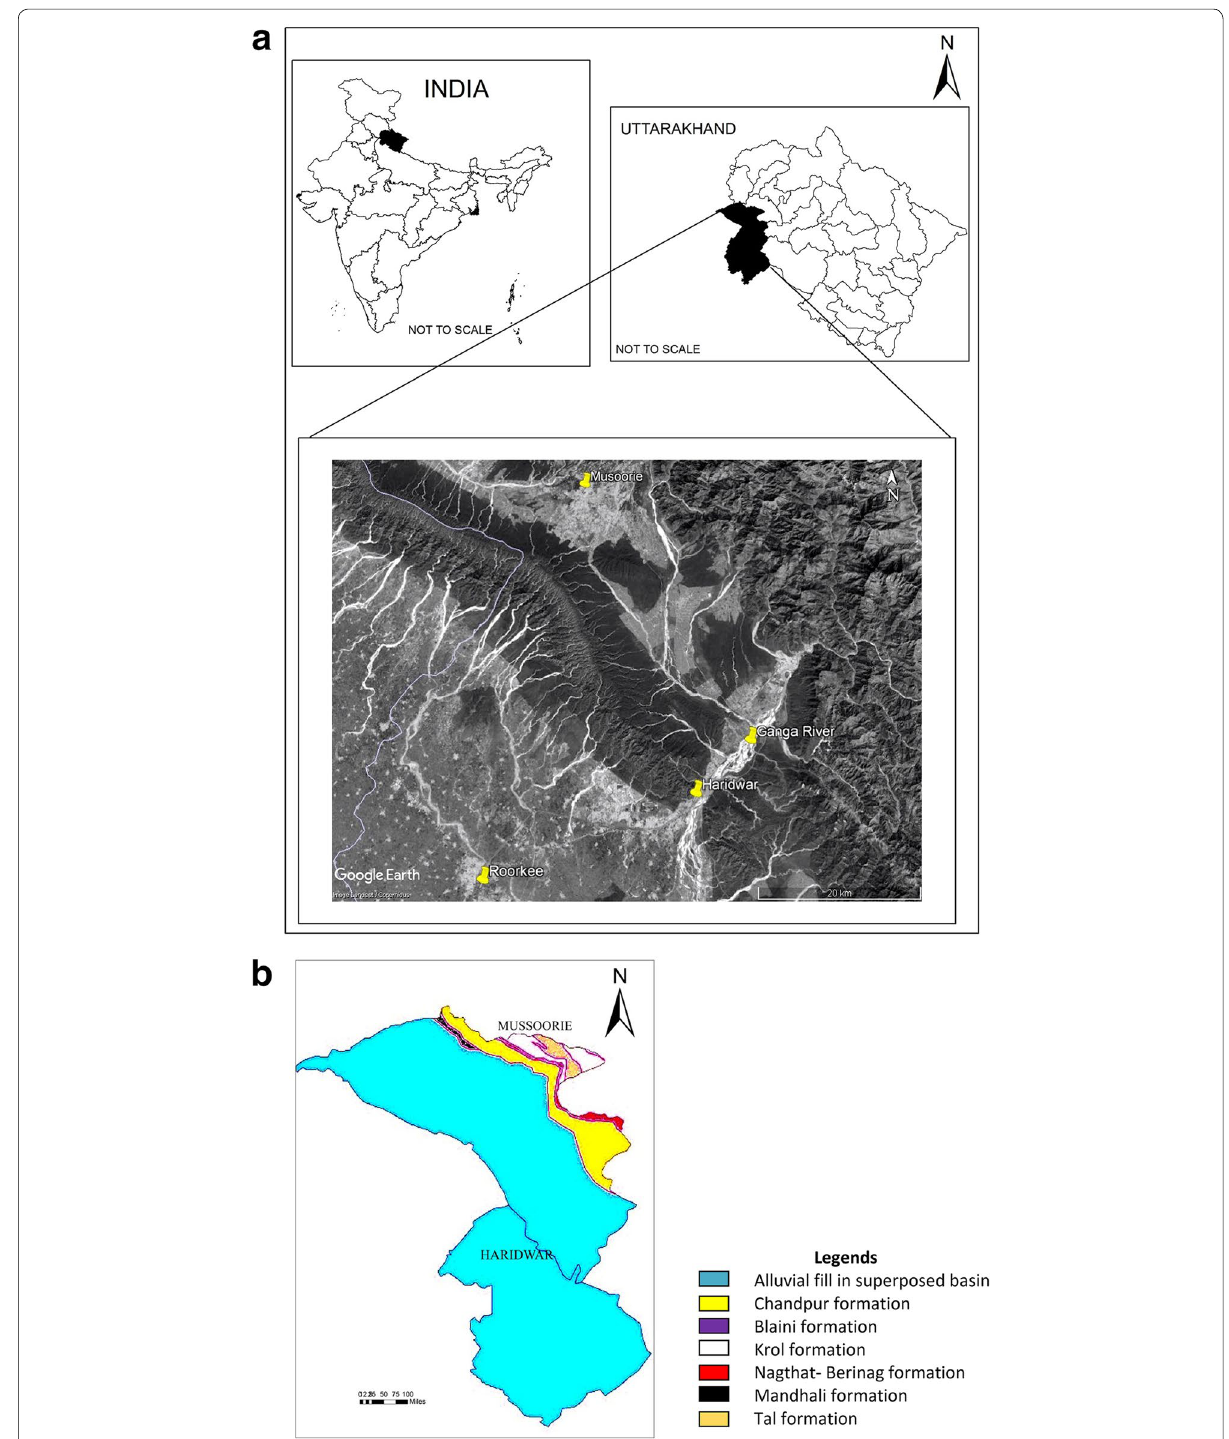
Fig. 1 The study area with a geo-morphological features and b geological